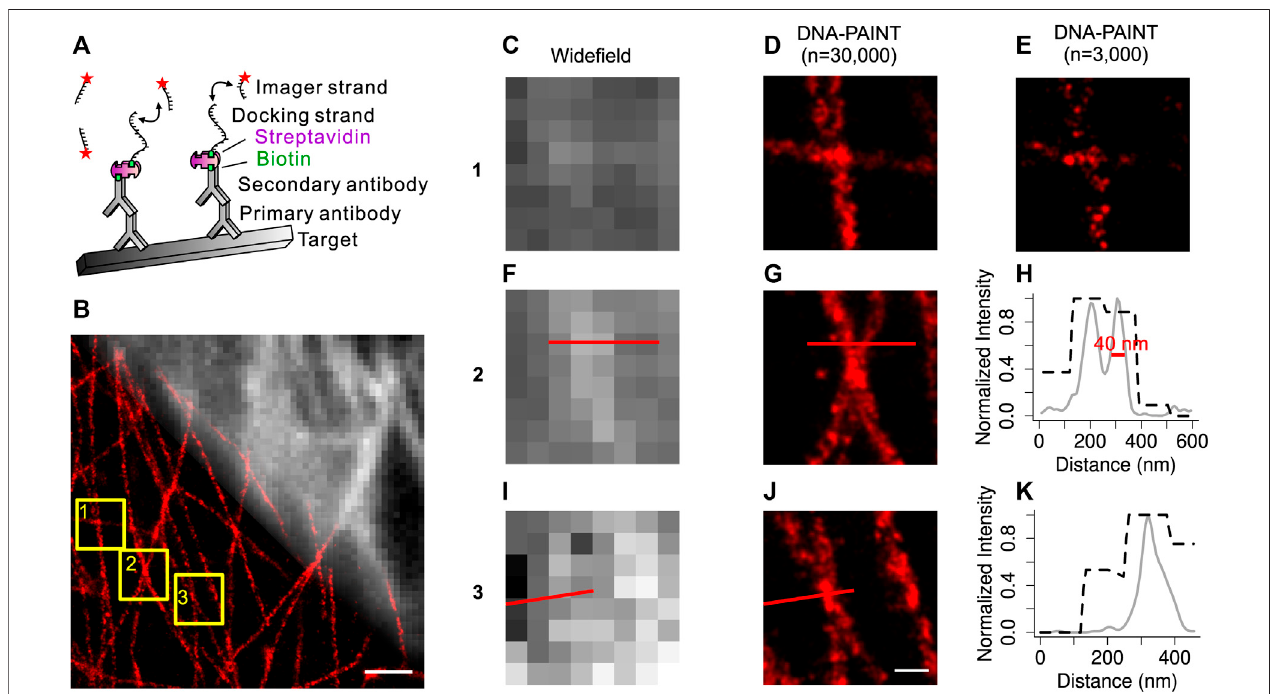
FIGURE1| DevelopmentoftheimprovedDNA-PAINTlabelingmethod. (A) OverviewoftheimprovedDNA-PAINTsystem.LabelingstrategyforDNA-PAINTusing antibodies, fl uorescentdye-conjugatedstreptavidin,dockingstrands,andcomplementaryimagerstrands. (B) Overlayofawide fi eldmicrotubuleimage(topright)withits DNA-PAINT reconstruction image (bottom left). (C) (F) (I) Wide fi eld images of the boxed regions 1, 2, 3 from (B) (D) (G) (J) DNA-PAINT reconstructions ( n = 30,000) of the same boxed regions 1,2, 3from (B) (E) Sparse localizationimage ( n =3,000)of (D) (H) Normalized intensity plotofregionsfrom F, (G) (K) Normalized intensity plotofregionsfromI, (J) .Blackdashedcurvesfromwide fi eldimages;graysolidcurvesfromDNA-PAINTreconstructions(n=30,000).Scalebar:1,000 nm (B) ,200 nm (J) . Machine learning approach for the DNA-PAINT image reconstruction.